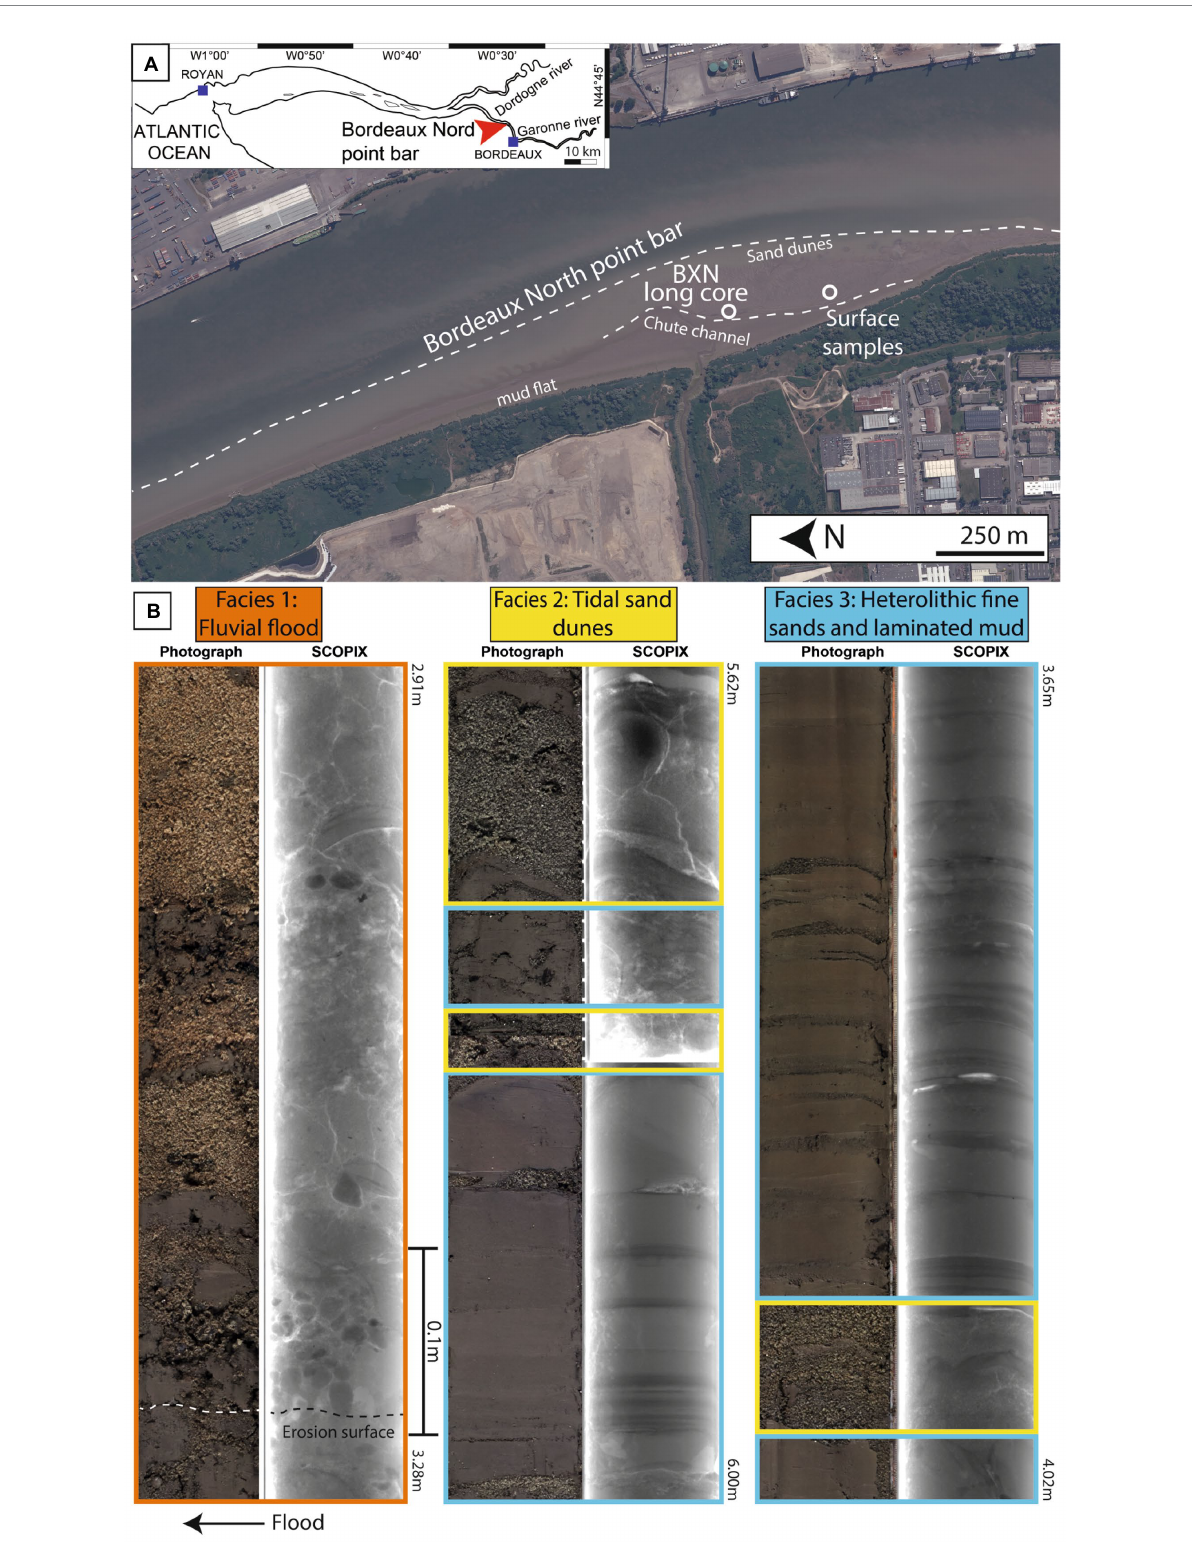
FIGURE 1 (A) Map of the Gironde estuary showing the location of the Bordeaux North point bar, and satellite image of the point bar at low tide (Google Earth Pro) showing the location of the studied core (BXN Long Core) and surface samples. Three sedimentary domains are visible in the intertidal zone of the point bar: the mud flat, the chute channel, and the sand dunes. (B) Photographs and X -Ray image (SCOPIX) of the principal facies found in the BXN long